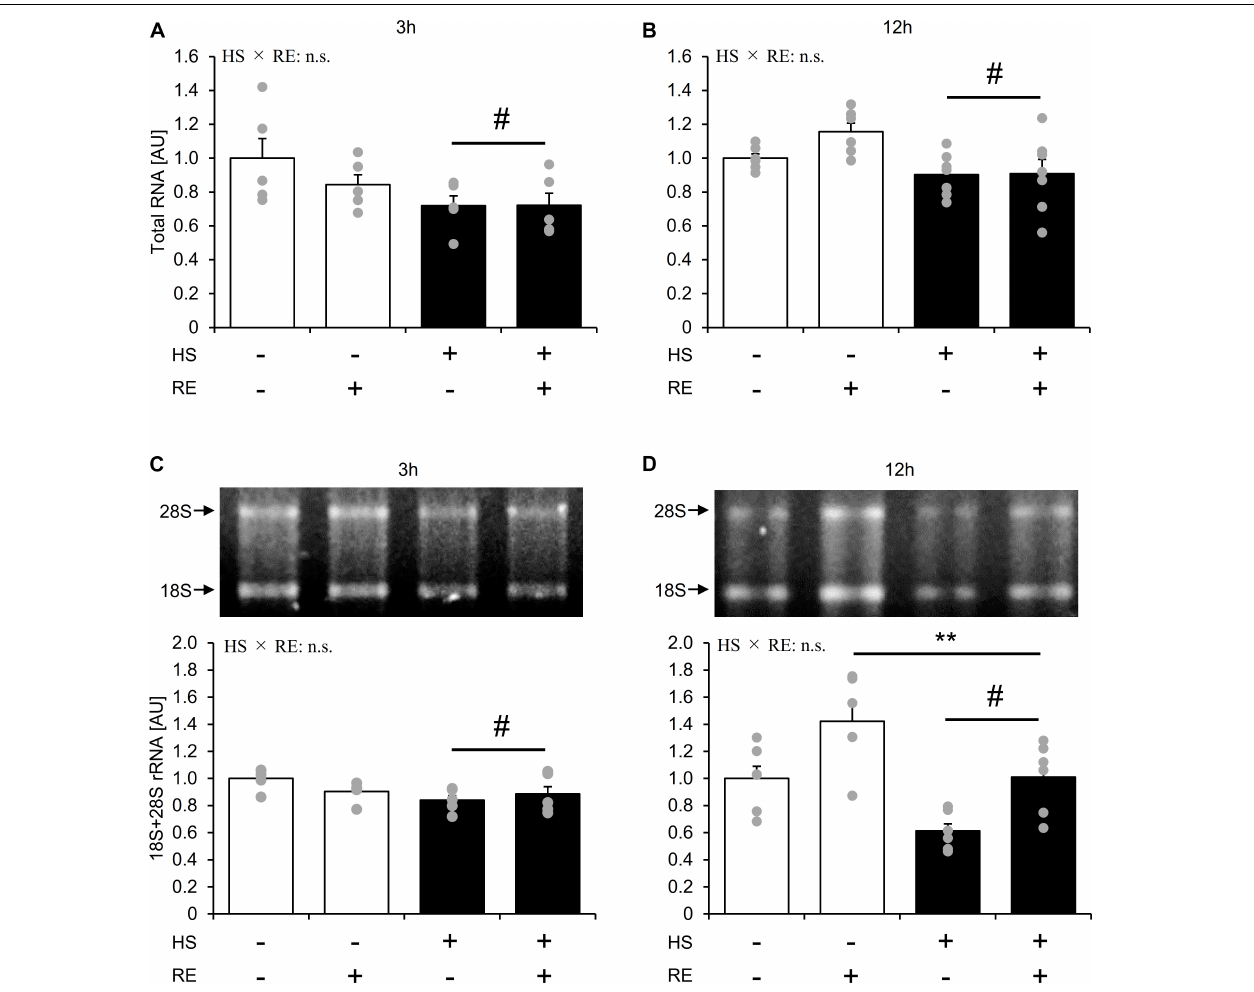
FIGURE 6 | The effect of an acute RE on ribosome RNA content after 14-days of hindlimb suspension. RNA content per mg tissue (A,B) . 18S + 28S ribosome RNA (C,D) . HS: hindlimb suspension. RE: acute resistance exercise. Values are means ± SE ( n = 5–6/group). Black line with **: main effect of RE ( p < 0.05). Black line with # : main effect of HS ( p <